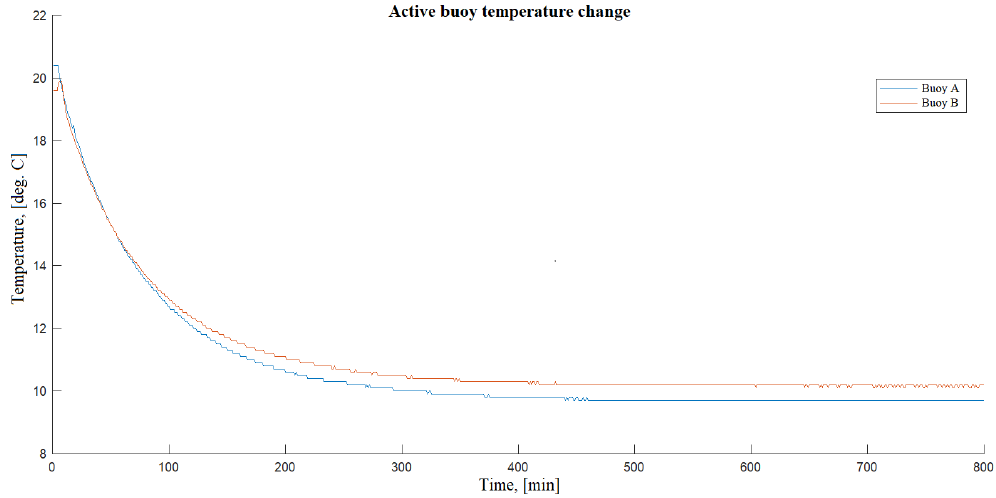
Figure 5. The process of cooling of the internal temperature of the buoys.